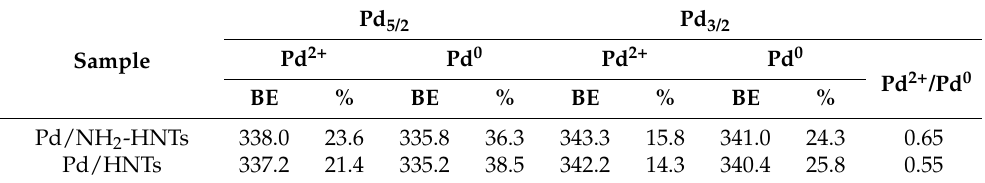
Table 2. Pd XPS analysis of